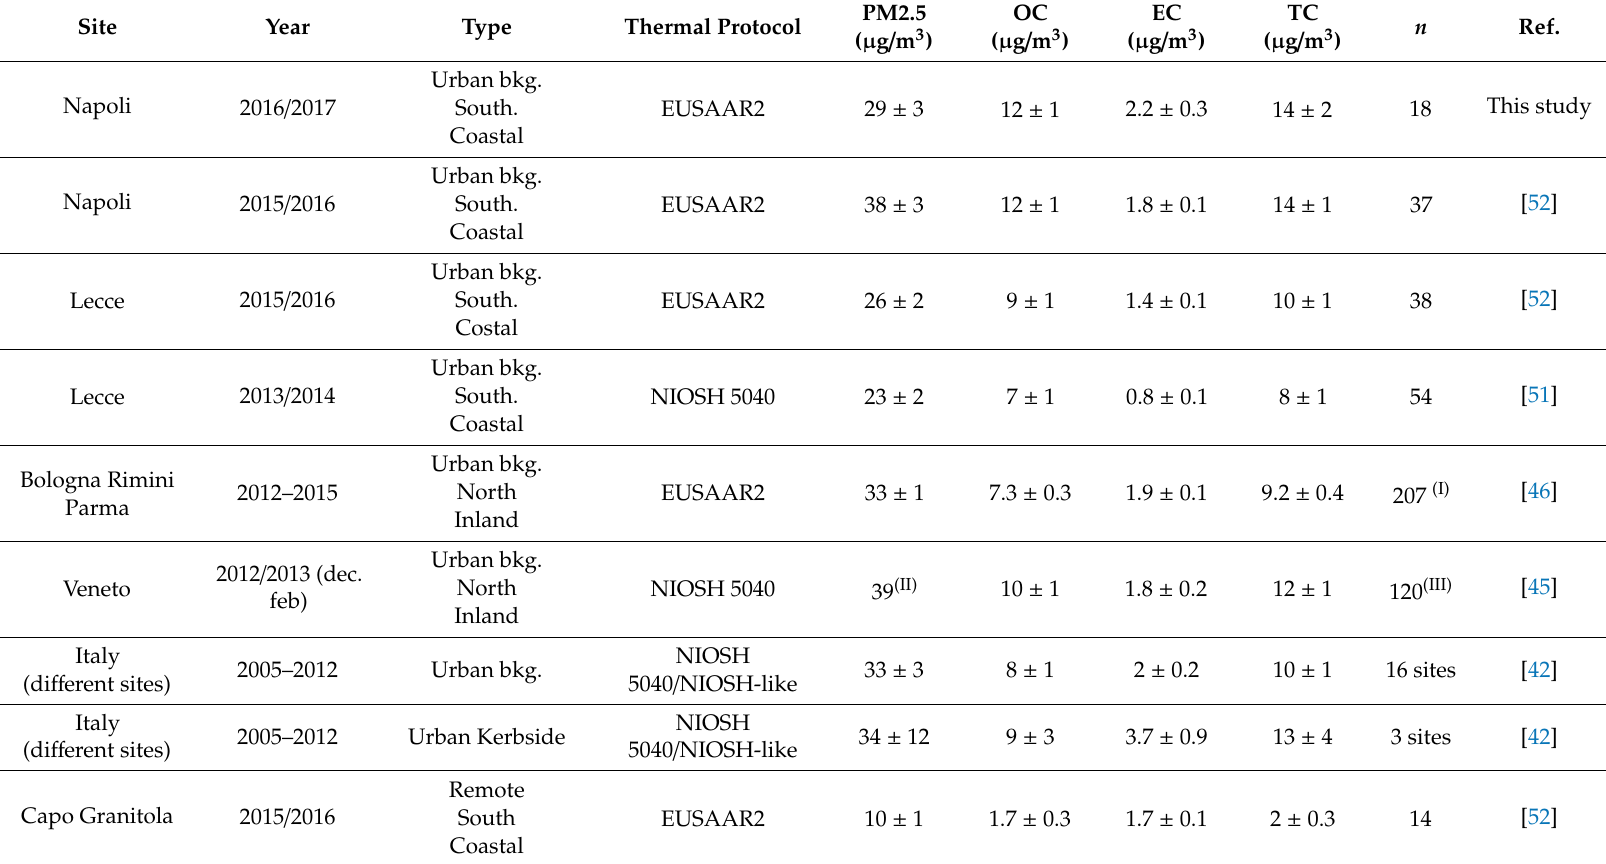
Table 2. PM 2.5 and carbonaceous fractions concentrations, from di ff erent studies and reviews conducted recently in Italy, during the cold season. The extent of each study is indicated in the column “n” by the number of samples or the number of sites investigated. The column “Year” indicates the year (or the years) of the sampling